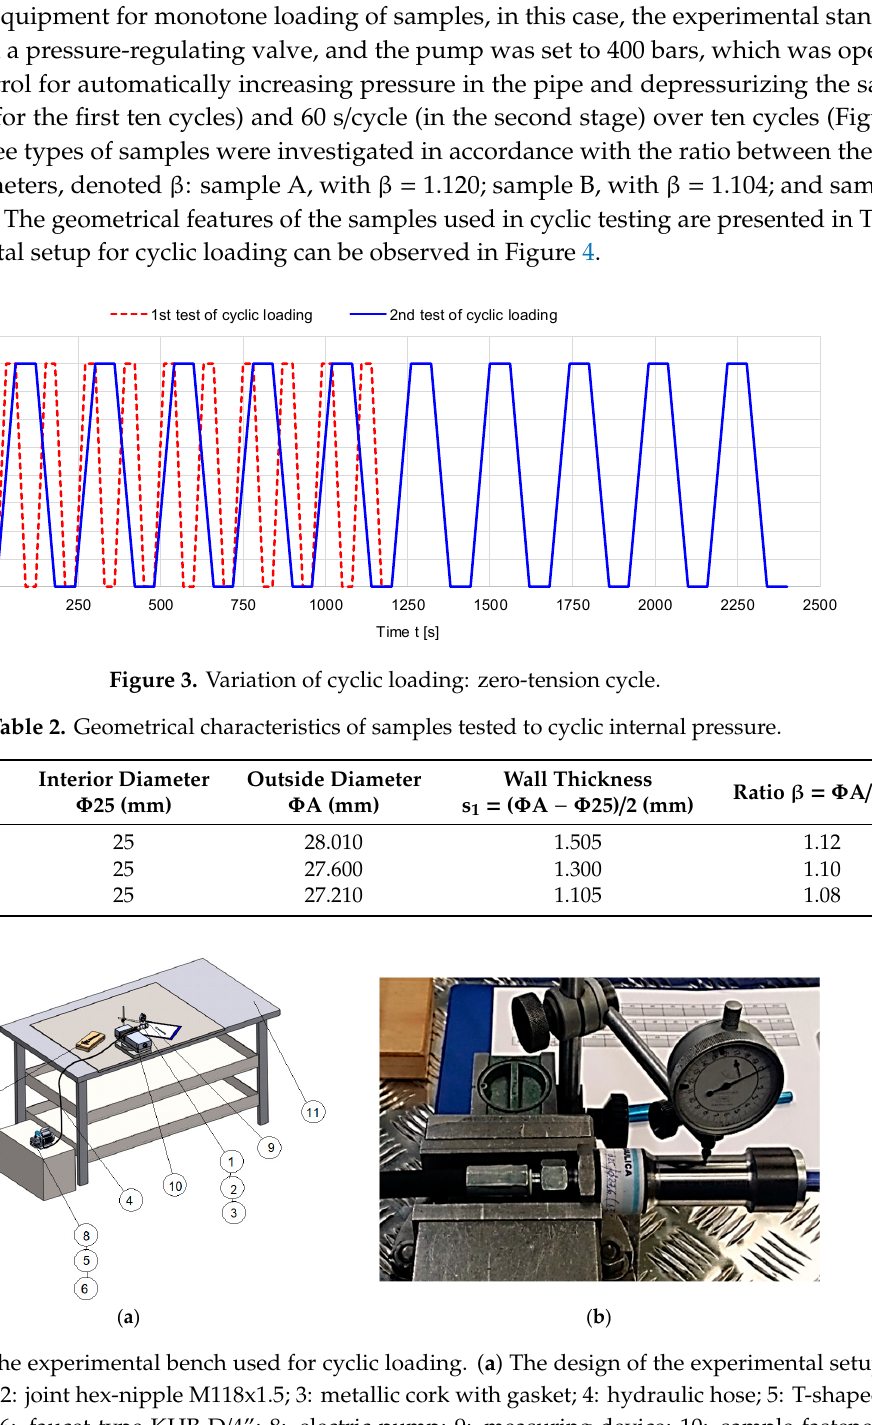
Table 2. Geometrical characteristics of samples tested to cyclic internal pressure.